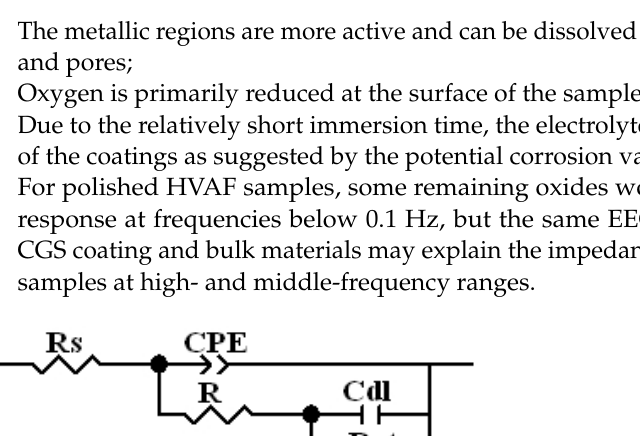
Table 4. Parameters of the EEC used to fit to the EIS experimental of different samples. Rs was normalized to the lower value measured for the samples (Rs = 16 Ω cm 2 ) to better represent all curves at the same graphic, and therefore, the Rs value was not added to the